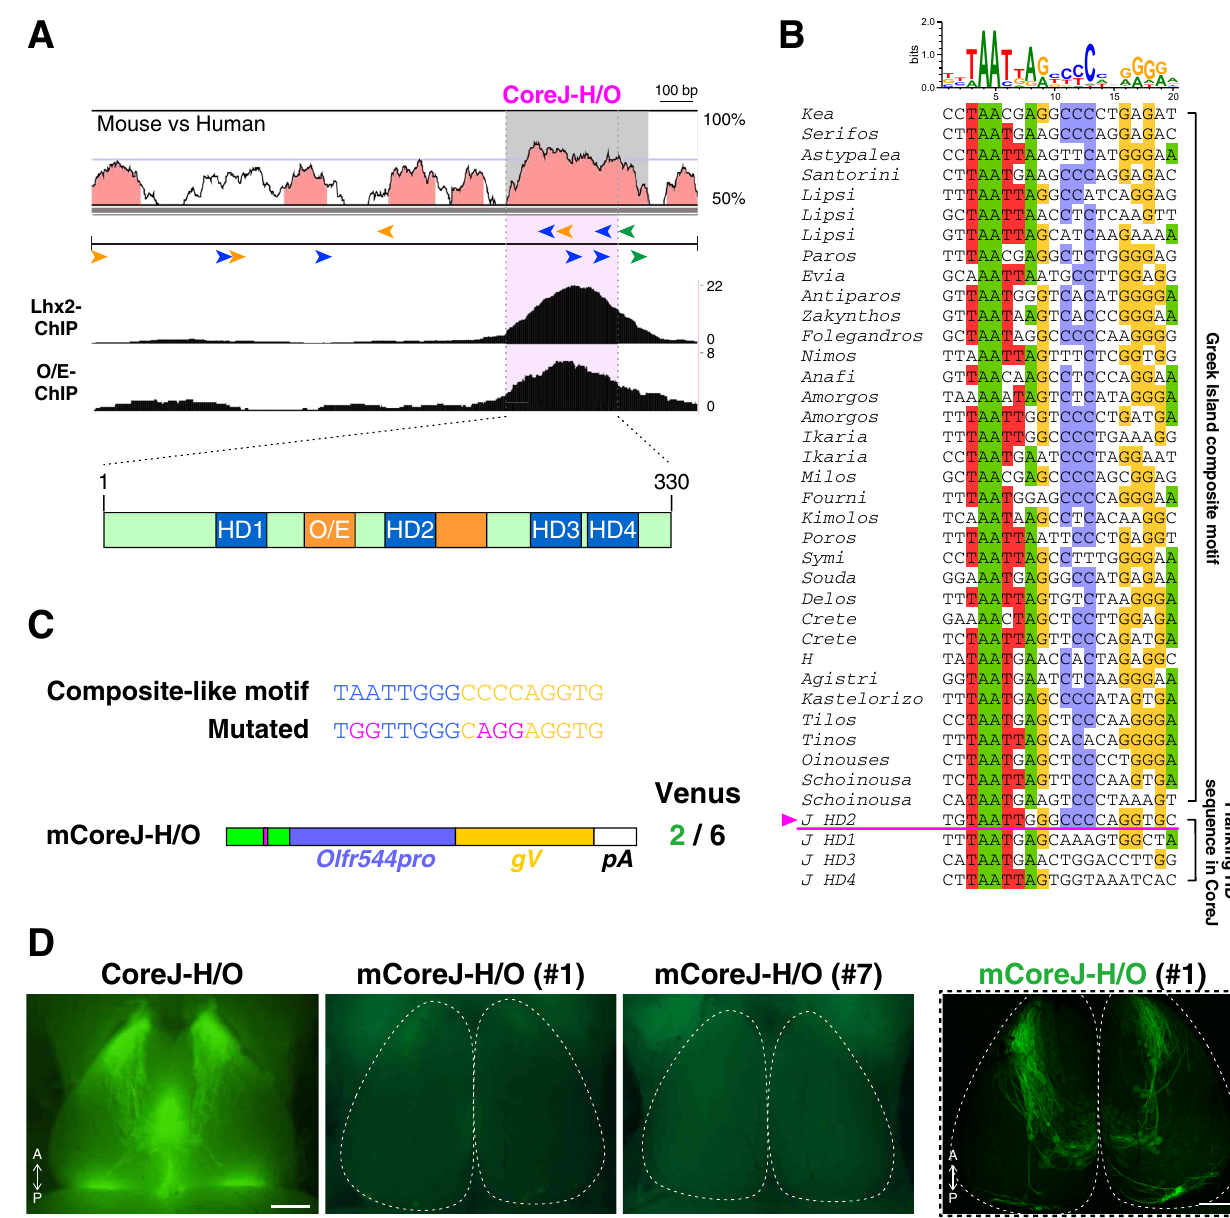
Figure 3. The composite motif in the core J element is essential for the enhancer activity. ( A ) ChIP-seq data of Lhx2 and O/E (Ebf) proteins. ChIP-seq peaks of Lhx2 and O/E are found in the core J-H/O sequence, suggesting that Lhx2 and O/E bind to the homeodomain and O/E-like sites in the core J-H/O element. The ChIP data were retrieved from GSE93570 30 . ( B ) Multiple alignment of the representative Greek Islands composite motifs in the class II enhancers and four homeodomain sites in the core J-H/O sequence (HD1–HD4 in ( A ). Comparison of the sequences revealed that the HD2 sequence belongs to the composite motif. A motif log shows all high-scored-composite motif sequence found in Greek island. Positions where matched nucleotides with at least 50% identity among the Greek island composite motifs are shaded by nucleotide identity: A = green, C = blue, G = yellow, T = red. ( C ) Schematic illustration of the mutations introduced into the composite motif and the mutated CoreJ-H/O transgene. The number of gapVenus-positive independent founders out of the total number analyzed is shown on the right. Note that two founders showed very weak fluorescent signals, which were hardly detected under the imaging conditions optimized to the CoreJ-H/O Tg mice. ( D ) Whole-mount fluorescent images of the dorsal OB of CoreJ-H/O and mCoreJ-H/O Tg mice. The left three panels are dorsal fluorescent images of the OBs of Core J-H/O (control) and mCoreJ-H/O (#1: very weak reporter expression; and #7: no reporter expression) Tg mice, taken under the same excitation and acquisition (gain and exposure time) conditions using a fluorescent stereomicroscope. The right panel is a confocal image to visualize the axonal projection domain of the founder #1, whose reporter expression was too weak to visualize in a fluorescent- stereomicroscopic image. Dotted lines indicate the OB outline. The scale bar is 500